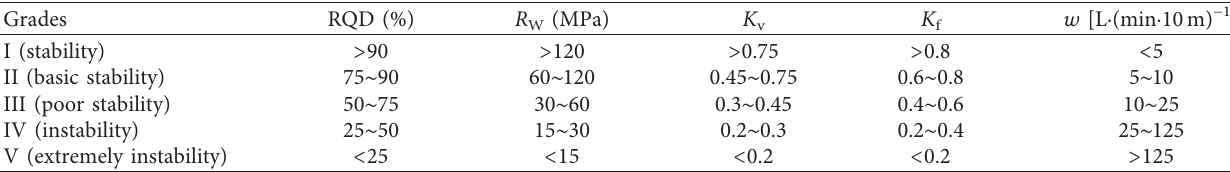
Table 2: Standard of underground engineering rock mass quality evaluation.